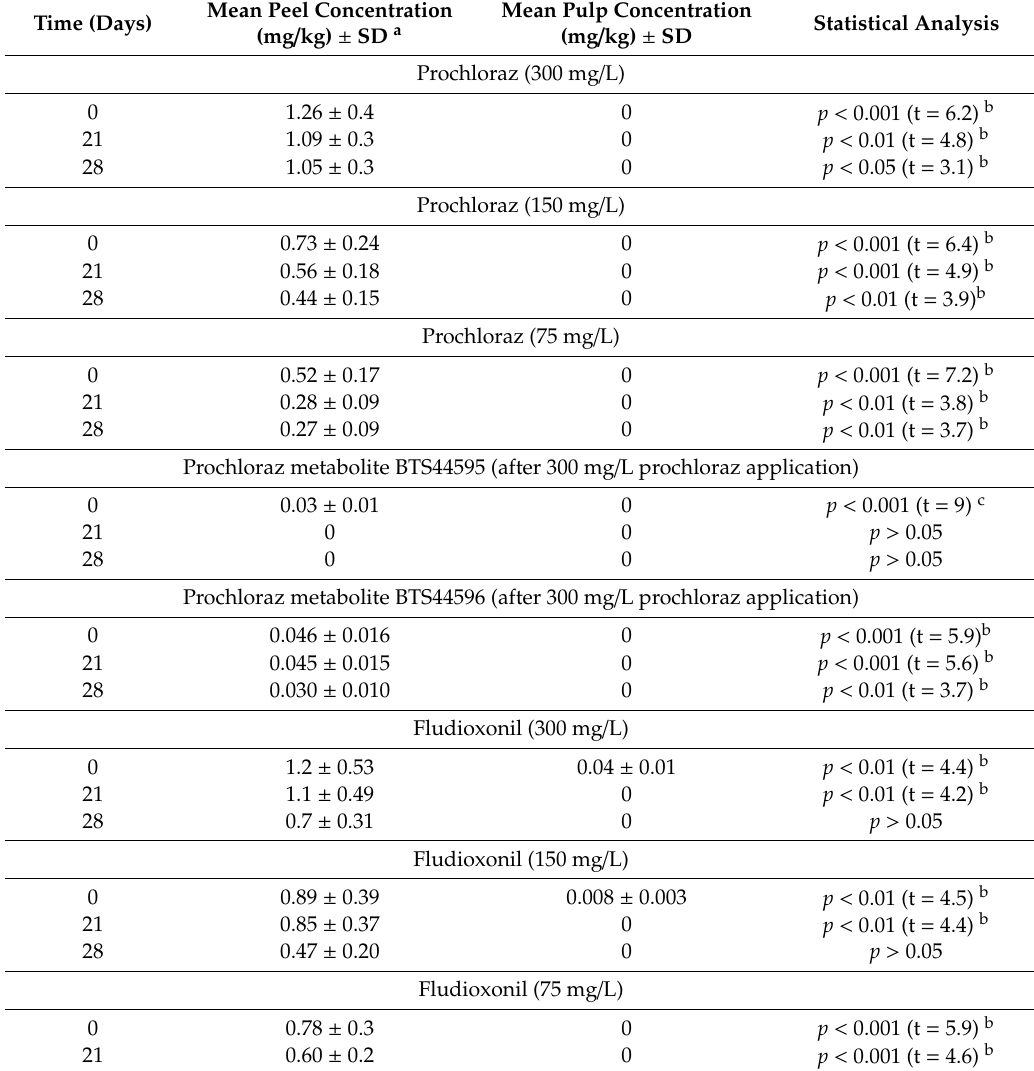
Table 2. Statistical comparison analysis of mean residual concentrations (mixed two-way ANOVA) of prochloraz and fludioxonil between peel and pulp of Reed